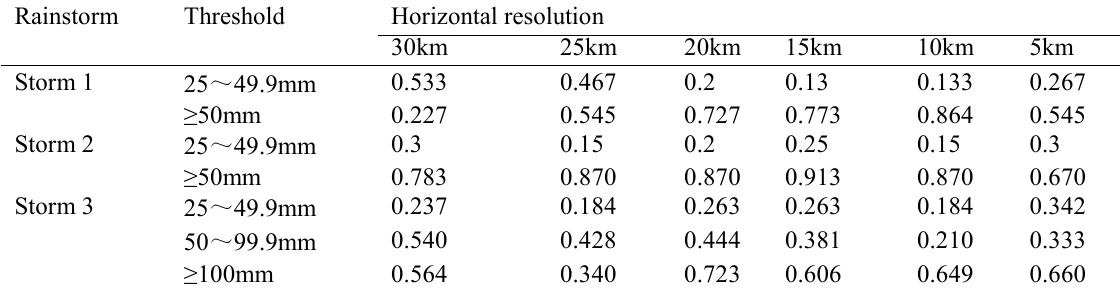
Table 3 Threat Scores of each simulation at different horizontal resolution Rainstorm